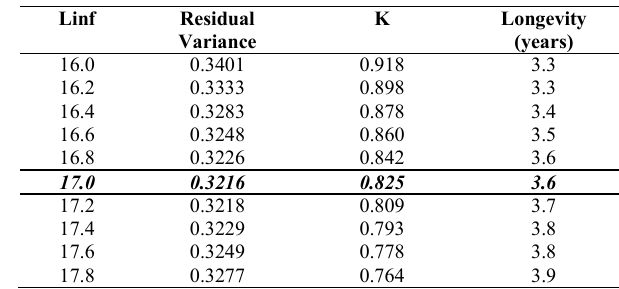
Table 6. Parameters of von Bertalanffy growth formulae for Atherinella brasiliensis females in southern Brazil and residual variance with different simulated asymptotic lengths. Longevity estimates defined as the time (years) to attain 95% of the asymptotic length. In italics are the data that result in the best